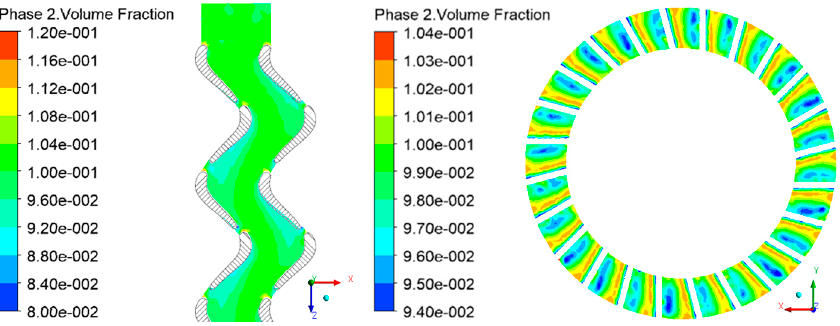
Figure 10. Volume fraction contour of turbodrill stages .